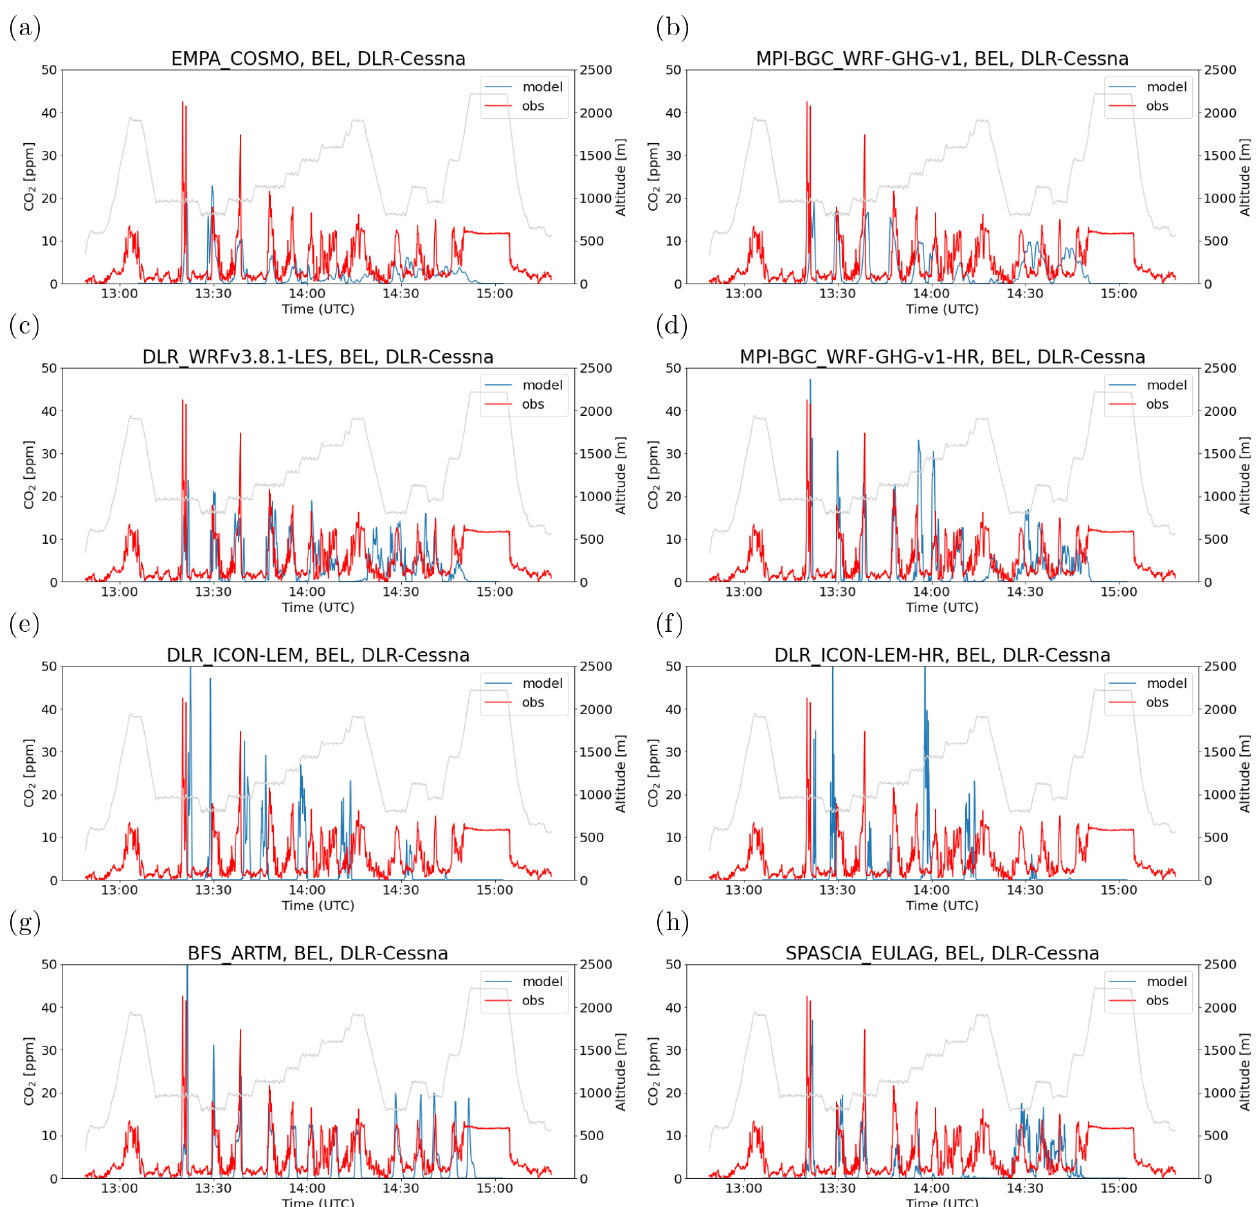
Figure 7. Time series of CO 2 (tracer CO2_PP_M) along the DLR Cessna flight at Bełchatów on 7 June 2018. The gray line is the flight altitude (second y